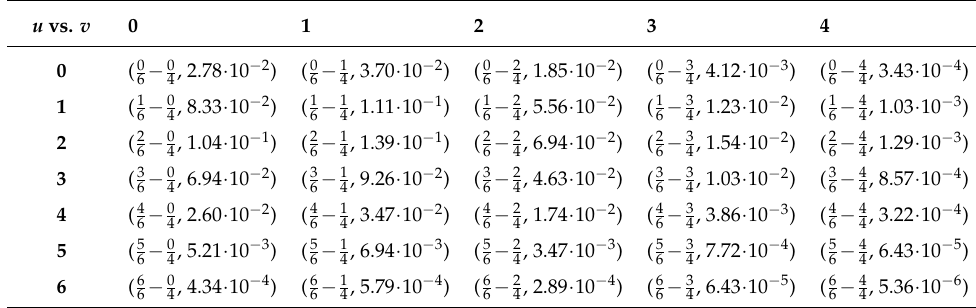
Table A1. Pairs of possible ERs and their associated probabilities ( h 1,2 , f 1,2 ) for the data in Table 2. u vs.